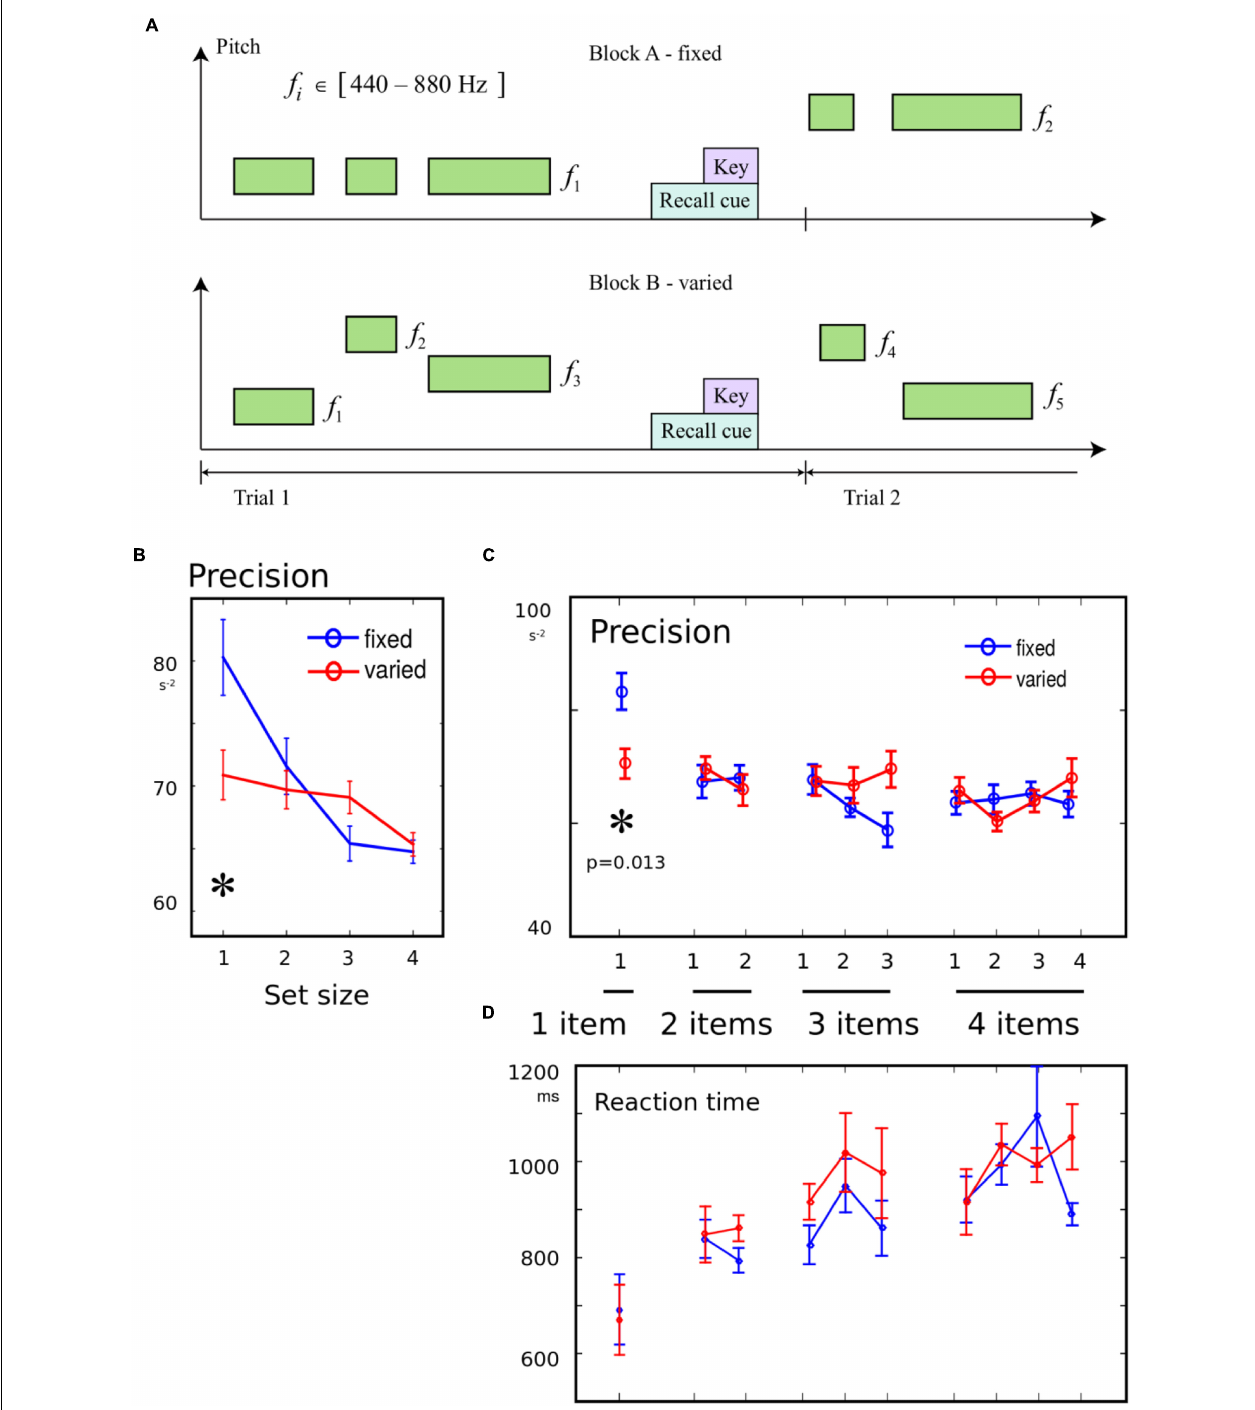
FIGURE 2 | (A) Variation in pitch was an irrelevant feature: To examine whether the introduction of an irrelevant variation in pitch would worsen recall, two of the four blocks had the same pitch for all tones in each trial (“fixed” condition). In the remaining blocks, each tone on every trial had a randomly chosen pitch (“variable” condition). Between 1 and 4 tones were presented on each trial. (B) Precision for a single tone was worse in variable block: When only one item had to be remembered, memory precision was worse in blocks where pitches varied from trial to trial, compared to blocks when they were constant. There was no effect of variability when multiple items had to be remembered. (C) No effect of variability on serial position effects: The trials were broken down according to serial position in the sequence. Although there was an interaction of variability with memory condition, the only effect of variability was seen for the one-tone condition. (D) No effect of variability on reaction time (RT): There were no differences in the time to initiate a response, between variable blocks and fixed blocks.